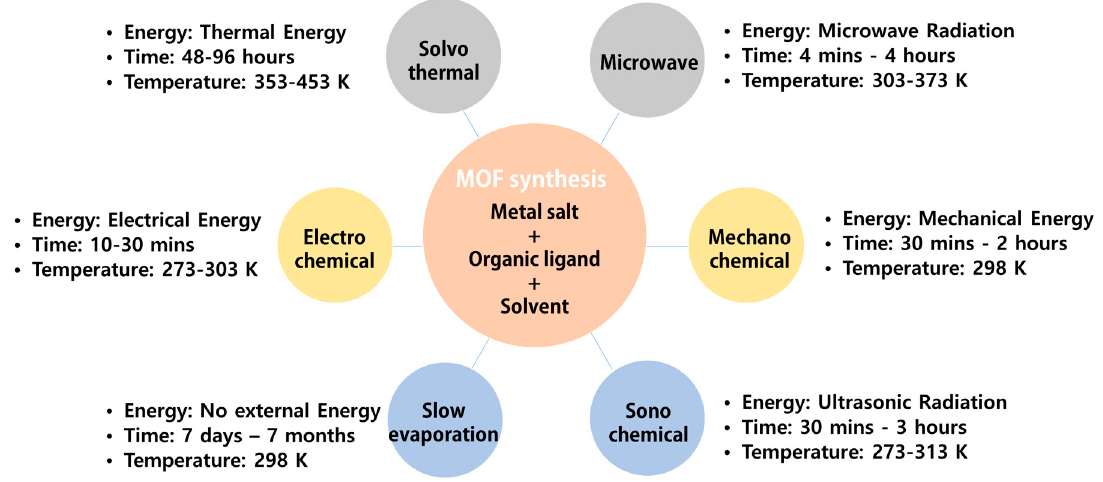
Figure 2. Summary of various MOF synthesis methods.